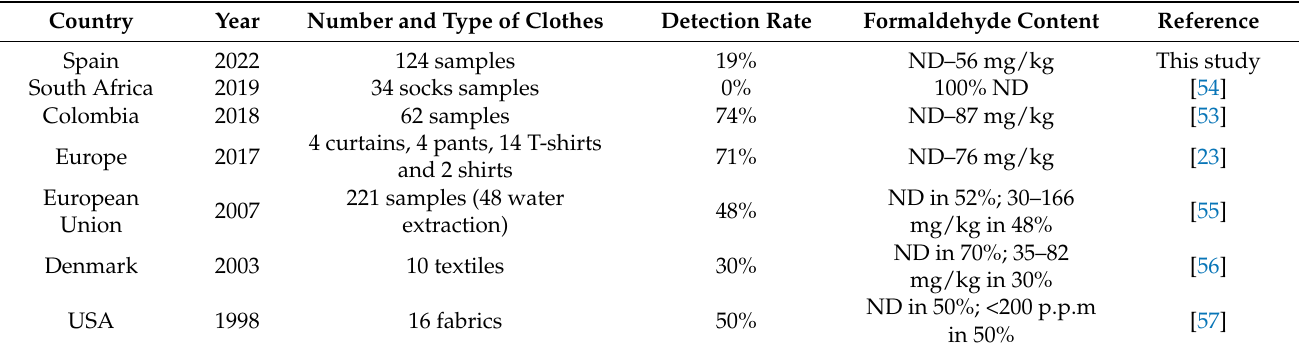
Table 5. Evolution of the concentration of formaldehyde in